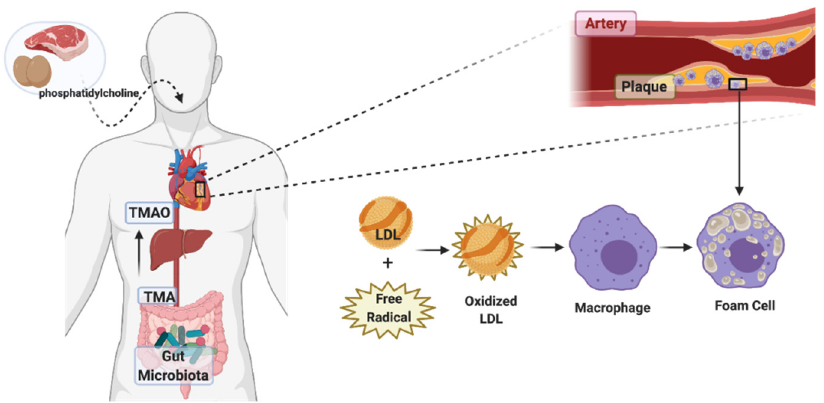
Figure 2. Role of trimethylamine N-oxide in atherosclerosis. Schematic pathway of phosphatidyl- choline transformation to TMA and TMAO (trimethylamine N-oxide) via the gut microbiota. Die- tary intake of foods like red meat and egg can alter the composition of gut microbiota. It can result in increased TMA production levels, subsequently leading to increased TMAO synthesis in the liver, eventually leading to elevated levels of oxidized LDLs and increased plaque formation. Ac- cumulated foam cells in the plaques are lipid-laden Macs that have ingested modified lipopro- teins, having a foamy appearance. In atherosclerosis, inflammatory Macs are converted into foam cells.